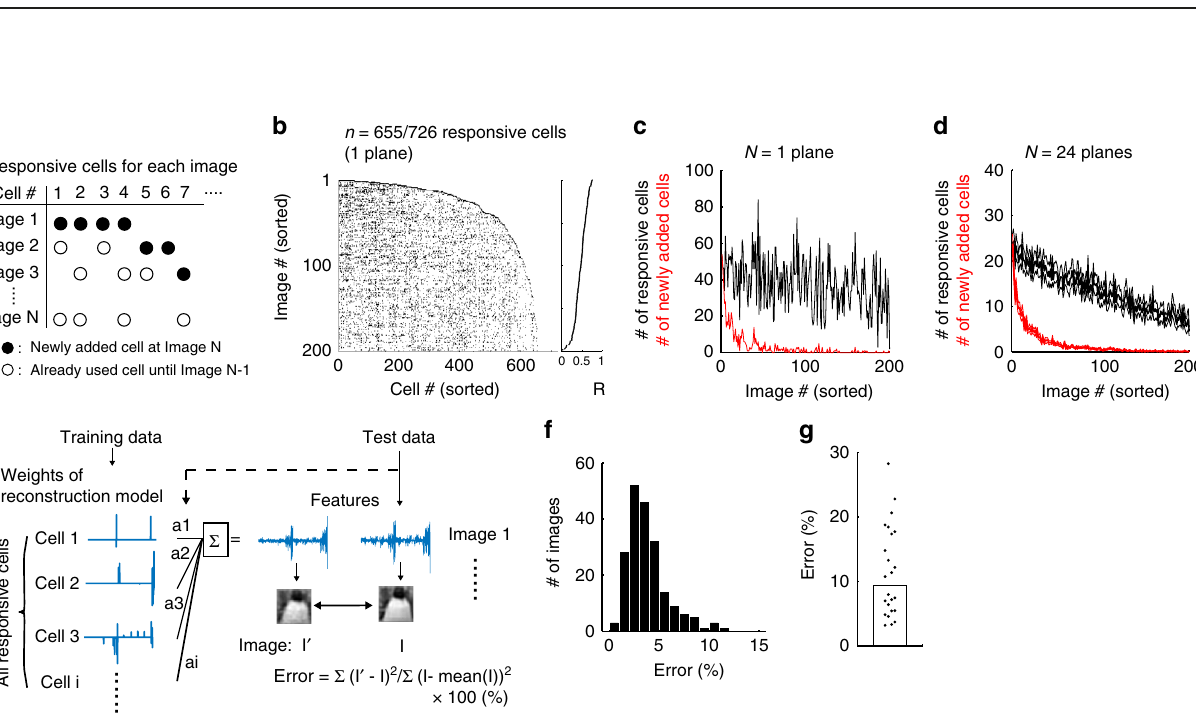
Fig. 6 Reliable image representation across trials. a Examples of single-trial reconstructed images (top) and response patterns in a FOV (bottom). The fi rst panel is a stimulus image, and the last panel is a trial-averaged image. FOV size: 507 micron each side. The color code for each dot indicates the response amplitude of each cell. b Single-trial evoked responses to the image in a . c Across-trial similarity of the reconstructed images (left) and the response patterns of responsive cells (right). The across-trial similarity was the Pearson ’ s correlation coef fi cient between a single-trial reconstructed image (or response pattern) and their trial average. d Across-trial variability of the reconstructed images (left) and the response patterns of responsive cells (right). The normalized squared error between a single-trial image (or response pattern) and their trial average was computed for the across-trial variability. e Reconstructed image from a set of overlapping cells (cell #1 – 9 in b ). Upper left: stimulus image and trial-averaged reconstructed images from the nine overlapping cells. Cyan dotted line: the overlapping area. Upper right: representation (reverse fi lters) of the overlapping cells. Red line: the representation area. Cell #1 was the reference cell. Lower: single-trial representation patterns of three example cells (cell #1, 2, and 3) selected from the overlapping cells. Bottom: single-trial reconstructed images (upper) and single-trial response patterns in an FOV (lower) obtained from the nine overlapping cells. The brightness of each color dot in the lower panels indicates response amplitude of each cell. f Across-trial variability of a local part of reconstructed image (cyan dotted line in e ) against the number of overlapping cells used for the reconstruction in the example case in e . Thick and thin lines are the median and 25th or 75th percentile, respectively ( n = 200 random sequences of cell adding). g Across-trial variability against the percentage of overlapping cells used for the reconstruction. Black lines: raw data. Orange lines: trial-shuf fl ed data. Thick and thin lines are median and 25th or 75th percentile, respectively. c , d , g N = 24 planes. The stimulus images in a and e are adapted from the database in ref. 56 with permission. Source data are provided as a Source Data fi le.